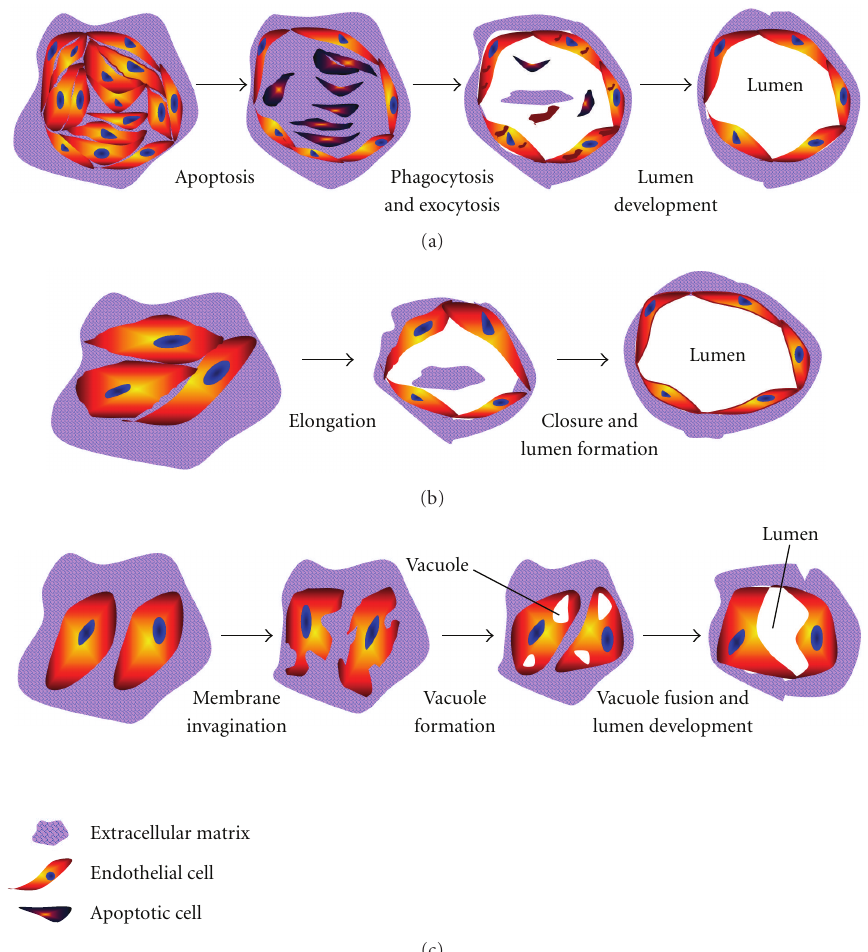
Figure 1: Models of the development of tube-like structures during